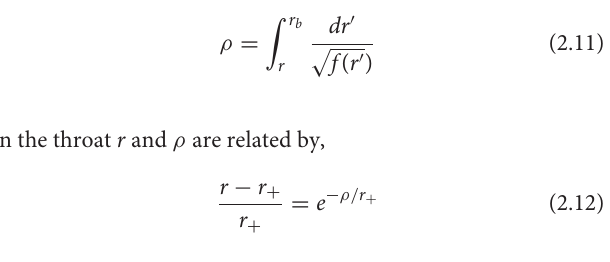
In Figure 2 , a Penrose diagram for a two-sided NERN black hole is shown along with the trajectories of the boundary and the regions beyond the boundary. The left-side boundary is shown in nature of the boundary is